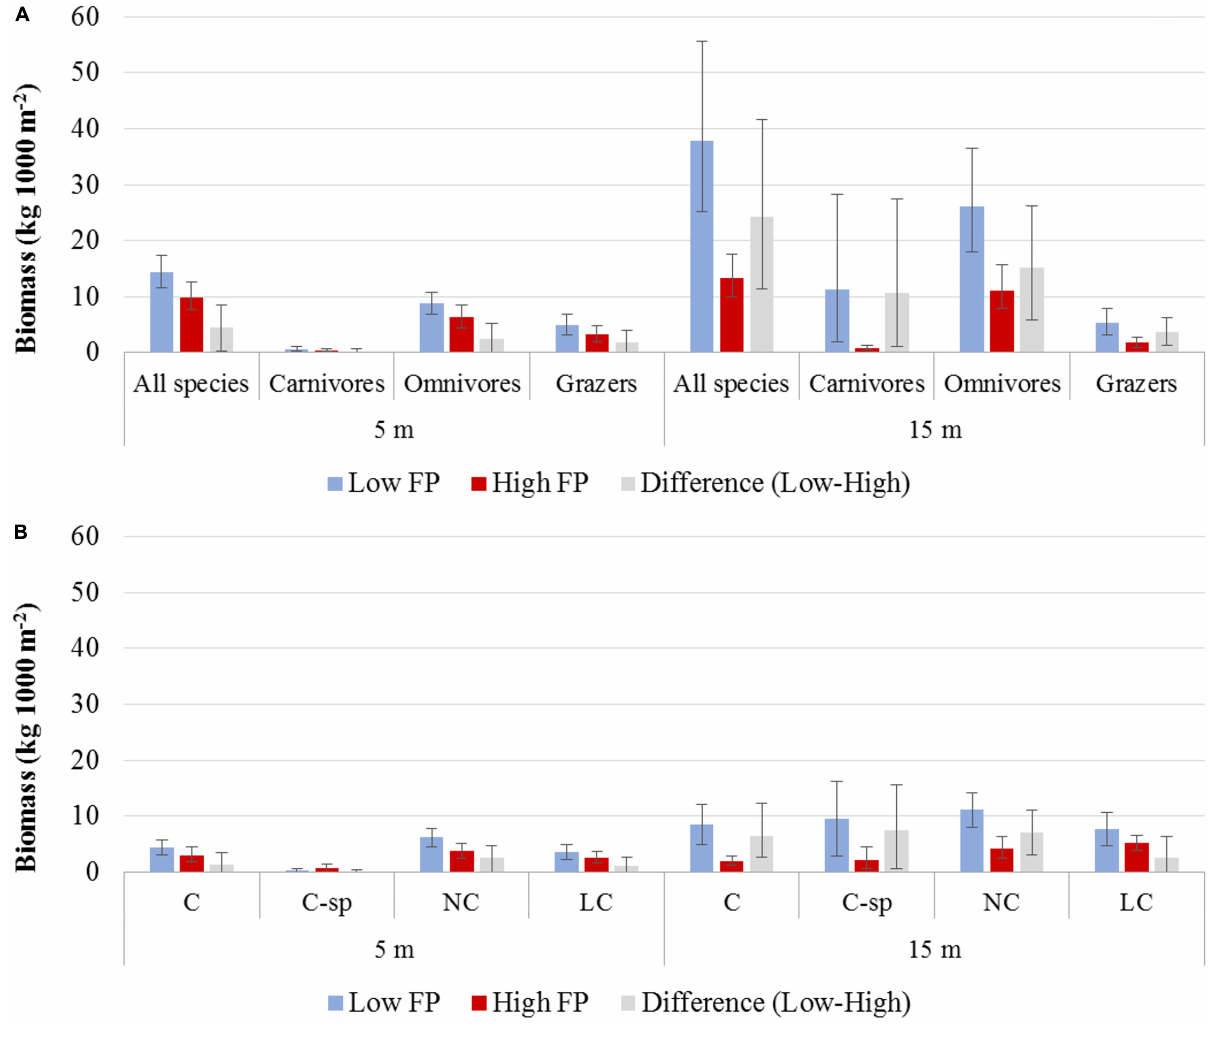
FIGURE 4 | Mean biomass and the 95% confidence interval (A) of total fish and trophic groups, and (B) of commercial status groups, for low and high fishing pressure (FP) sites, as well as their difference (Low – High), at the 5 and 15 m depth zones. C, commercial; C-sp, commercial small pelagic; NC, non-commercial; LC, non-commercial or sold in some areas but at low